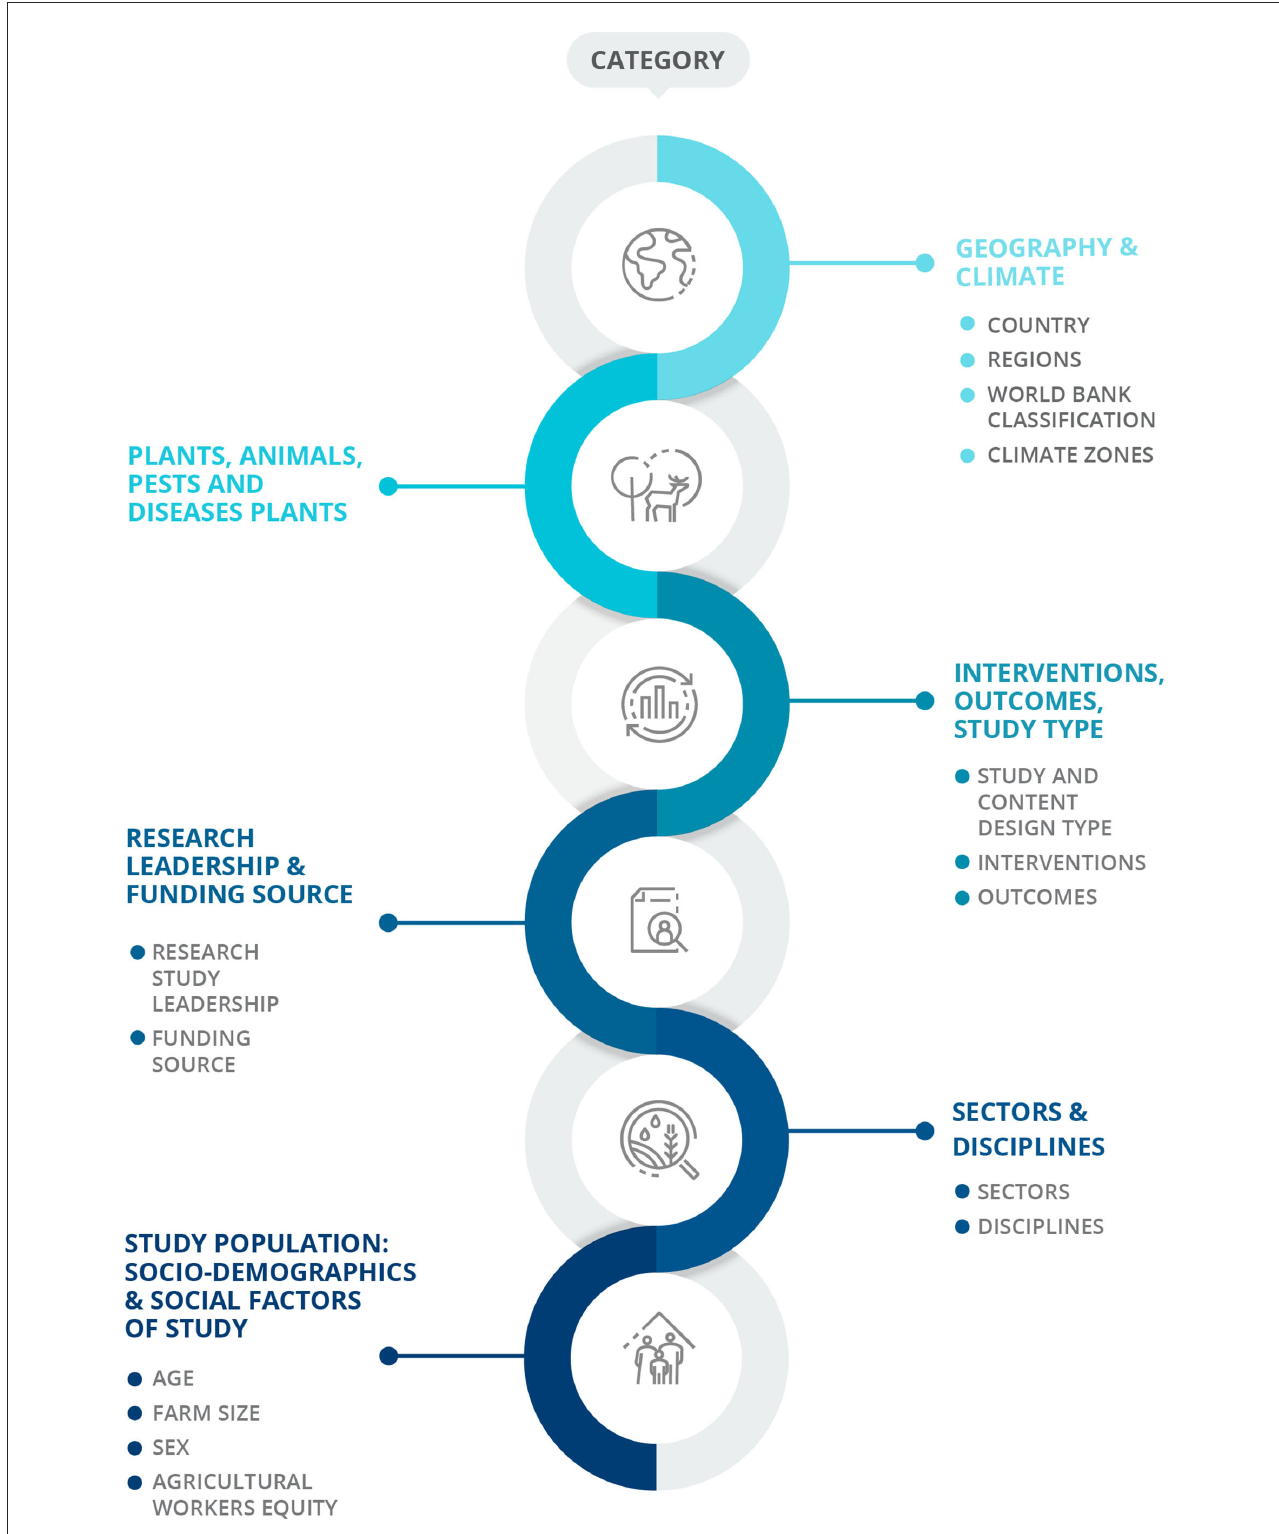
FIGURE1 The various categories into which unstructured text summaries were analyzed using AI-assisted techniques.